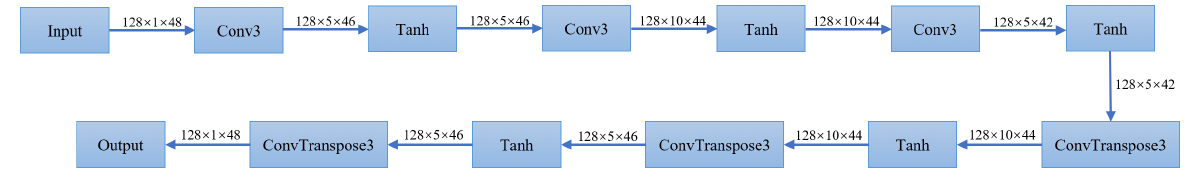
Figure 1. The neural network structure of the CAE based filter.